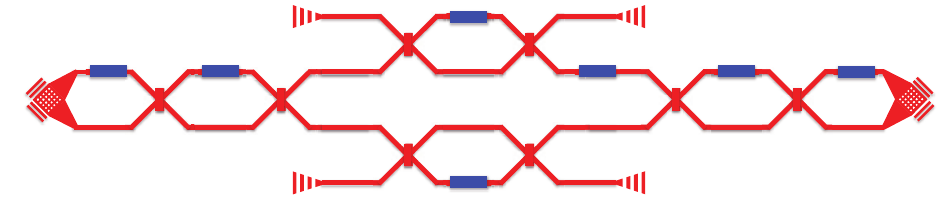
Figure 8: Photonic polarization processing circuits for polarization-based coordinate